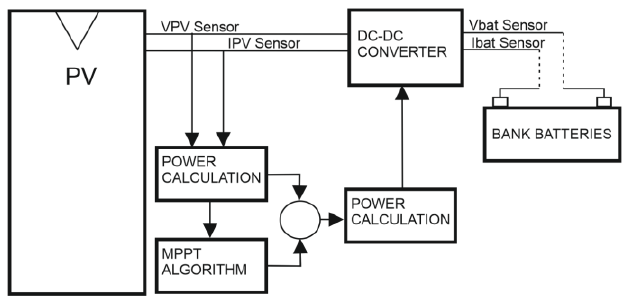
Figure 3. MTTP charge regulator block diagram.